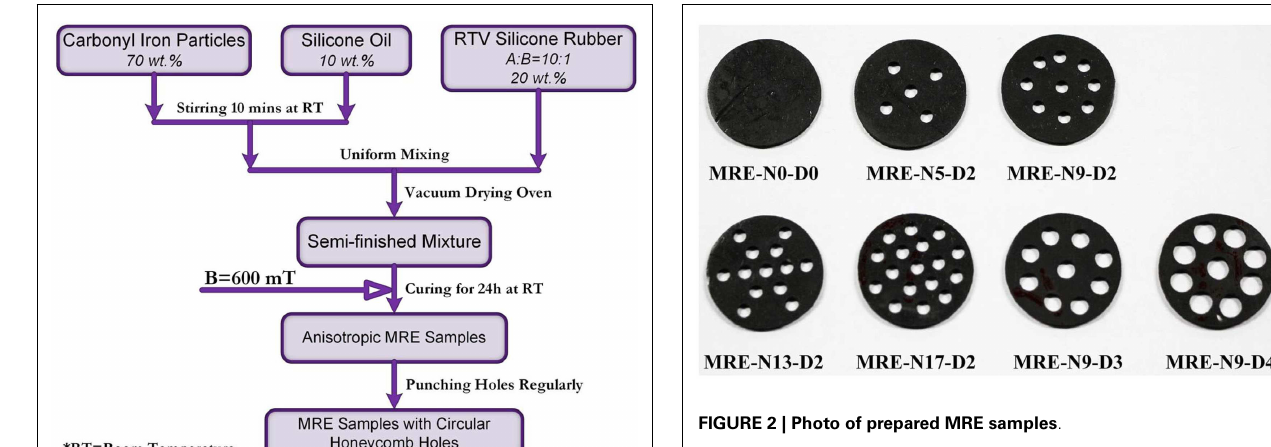
FIGURE 2 | Photo of prepared MRE samples .